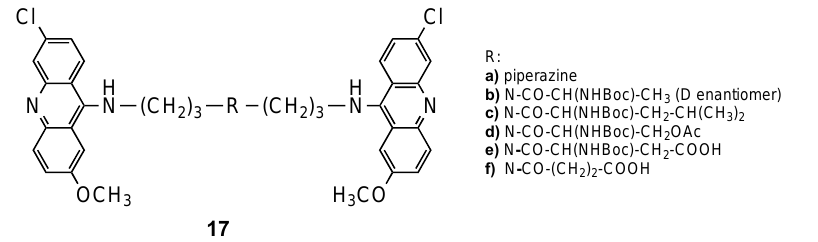
Figure 11. The best compounds 17 developed by Girault and co-workers [26].